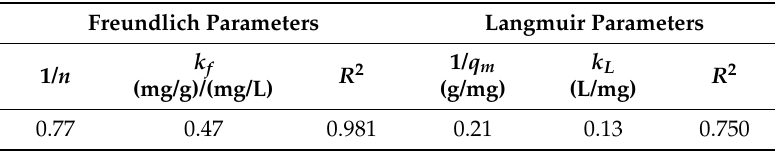
Table 4. Isotherm constants for ammonium